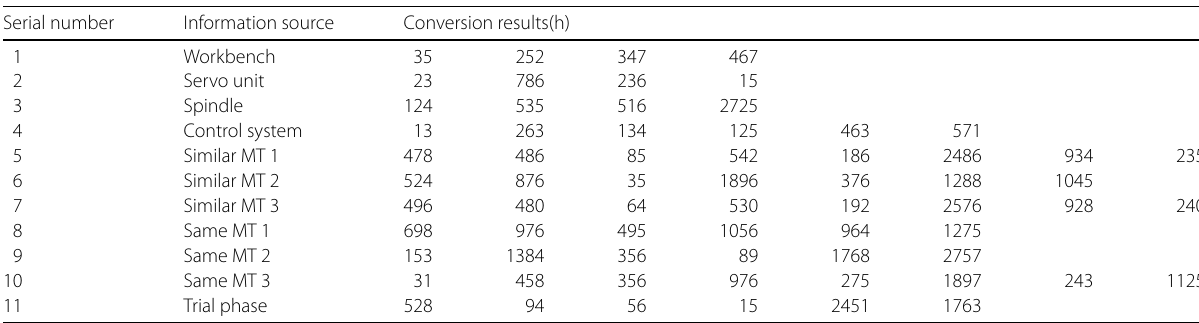
Table 2 Fault data after converted